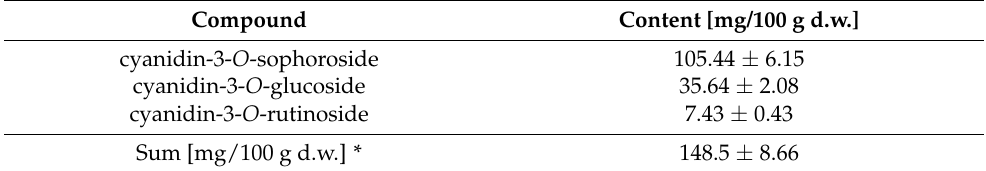
Table 1. Quantitative anthocyanin profile (mg/100 g d.w.) in freeze-dried raspberry